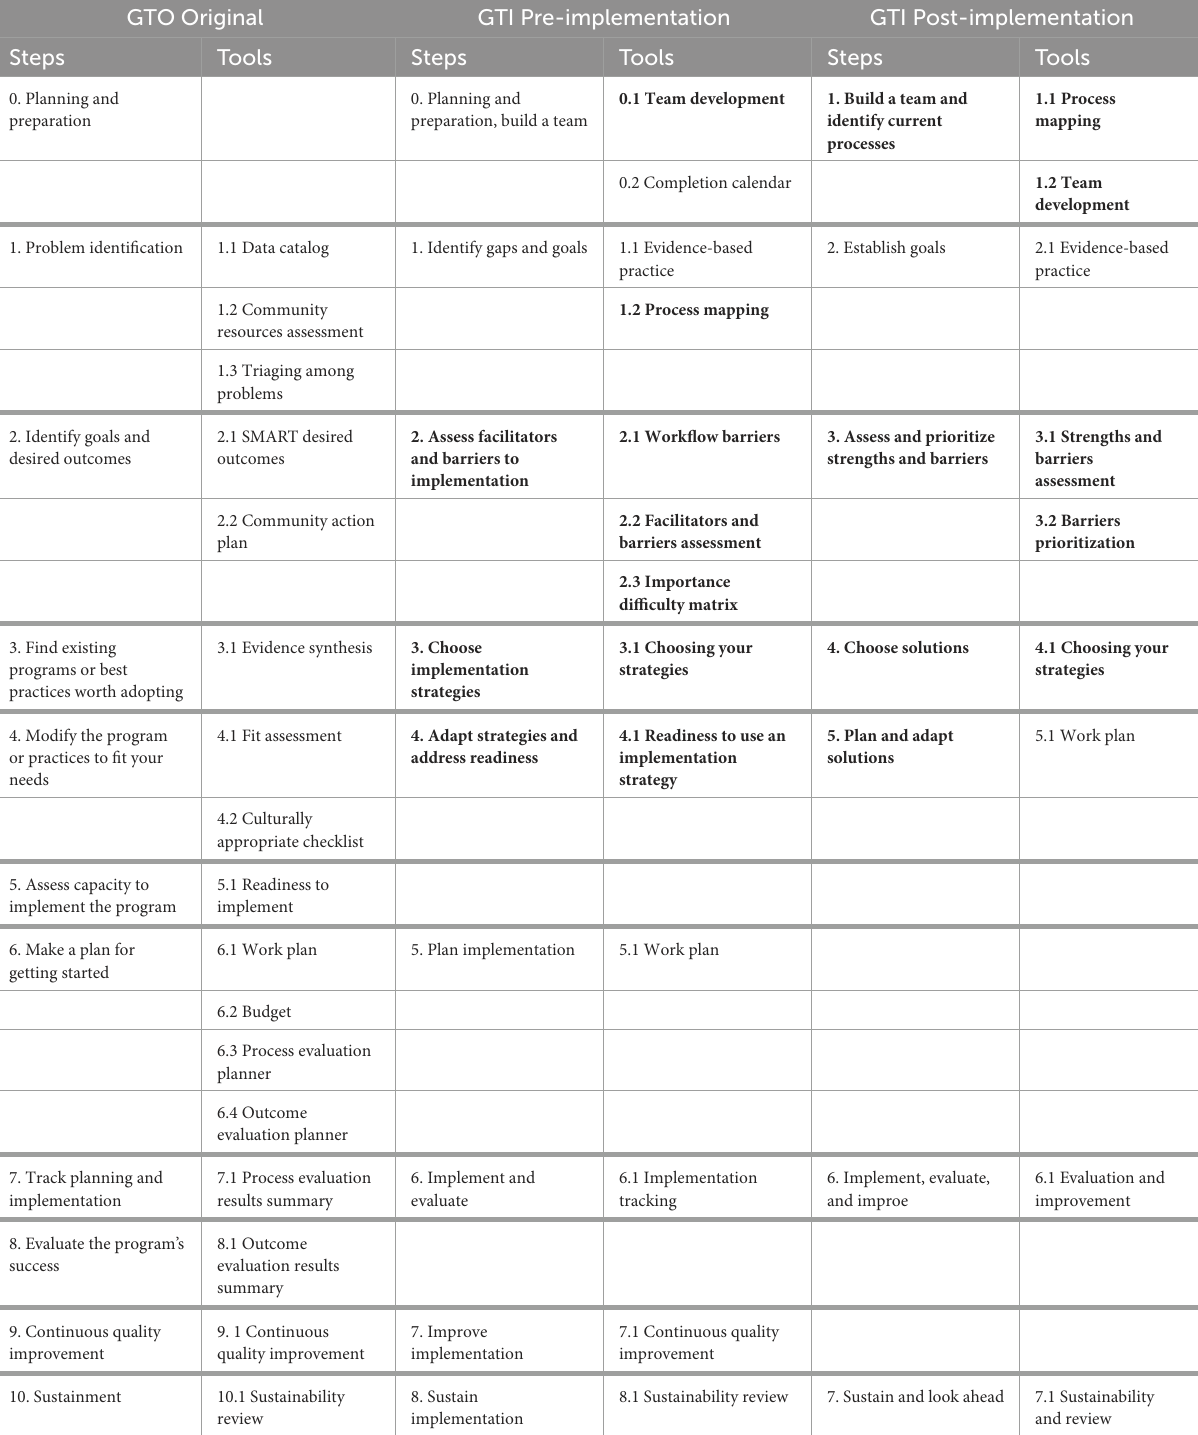
TABLE 2 GTO to GTI adaptations and modifications over time. GTO